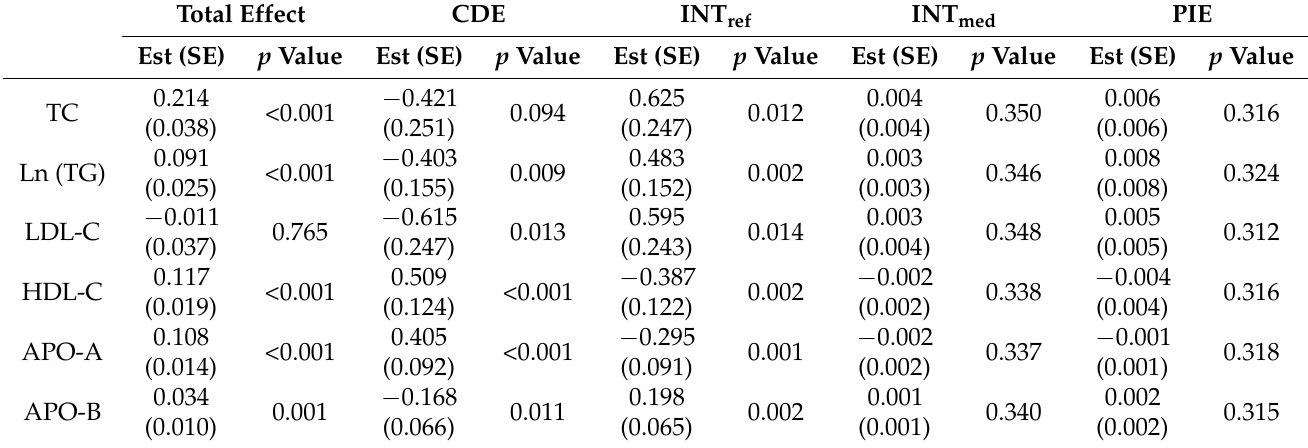
Table 2. The effect of drinking on lipids due to mediation and interaction with